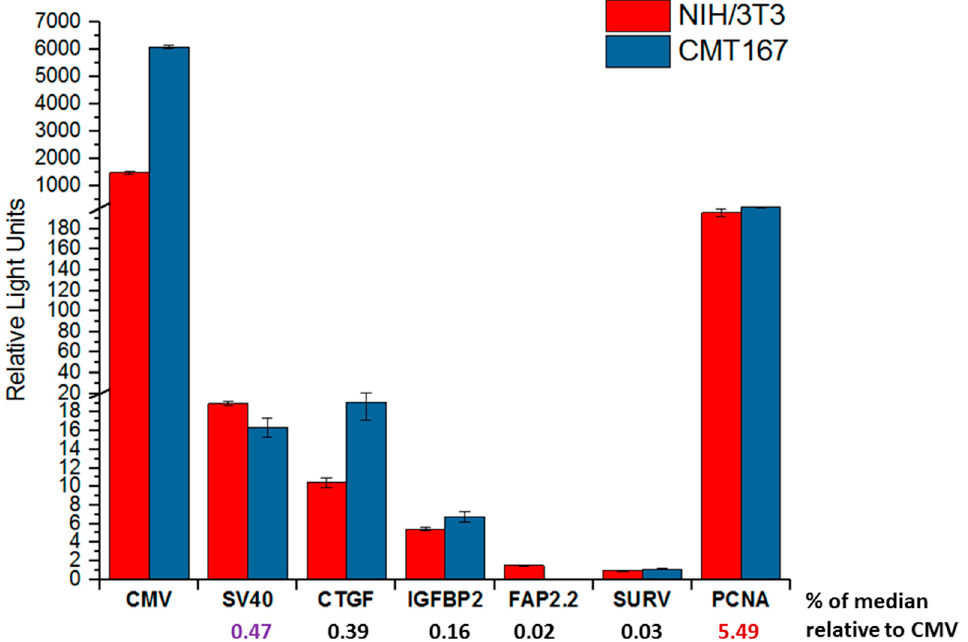
Figure 5. Relative promoter activities of the studied promoters in mouse cell lines. The graph represents relative promoter activities (Y-axis) as ratios of the luciferase activity expressed by plasmids containing promoters under study to the R. reniformis luciferase activity. Luciferase activity expressed by promoterless pGL3-basic plasmid was subtracted. Mean values (± s.e.m.) of relative luciferase activity were calculated from at least three independent experiments. The Y-axis serifs designate scale breaks. The names of promoters are indicated below the X-axis. The numbers under the names of promoters indicate the median activity of promoters in mouse cell lines relative to the activity of the CMV promoter. Median promoter activities higher than SV40 (purple) are shown in red.